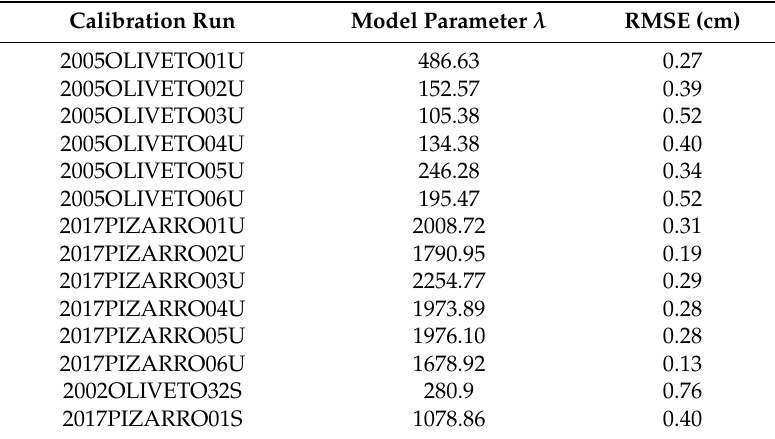
Table 2. Steady and unsteady calibration of the BRISENT